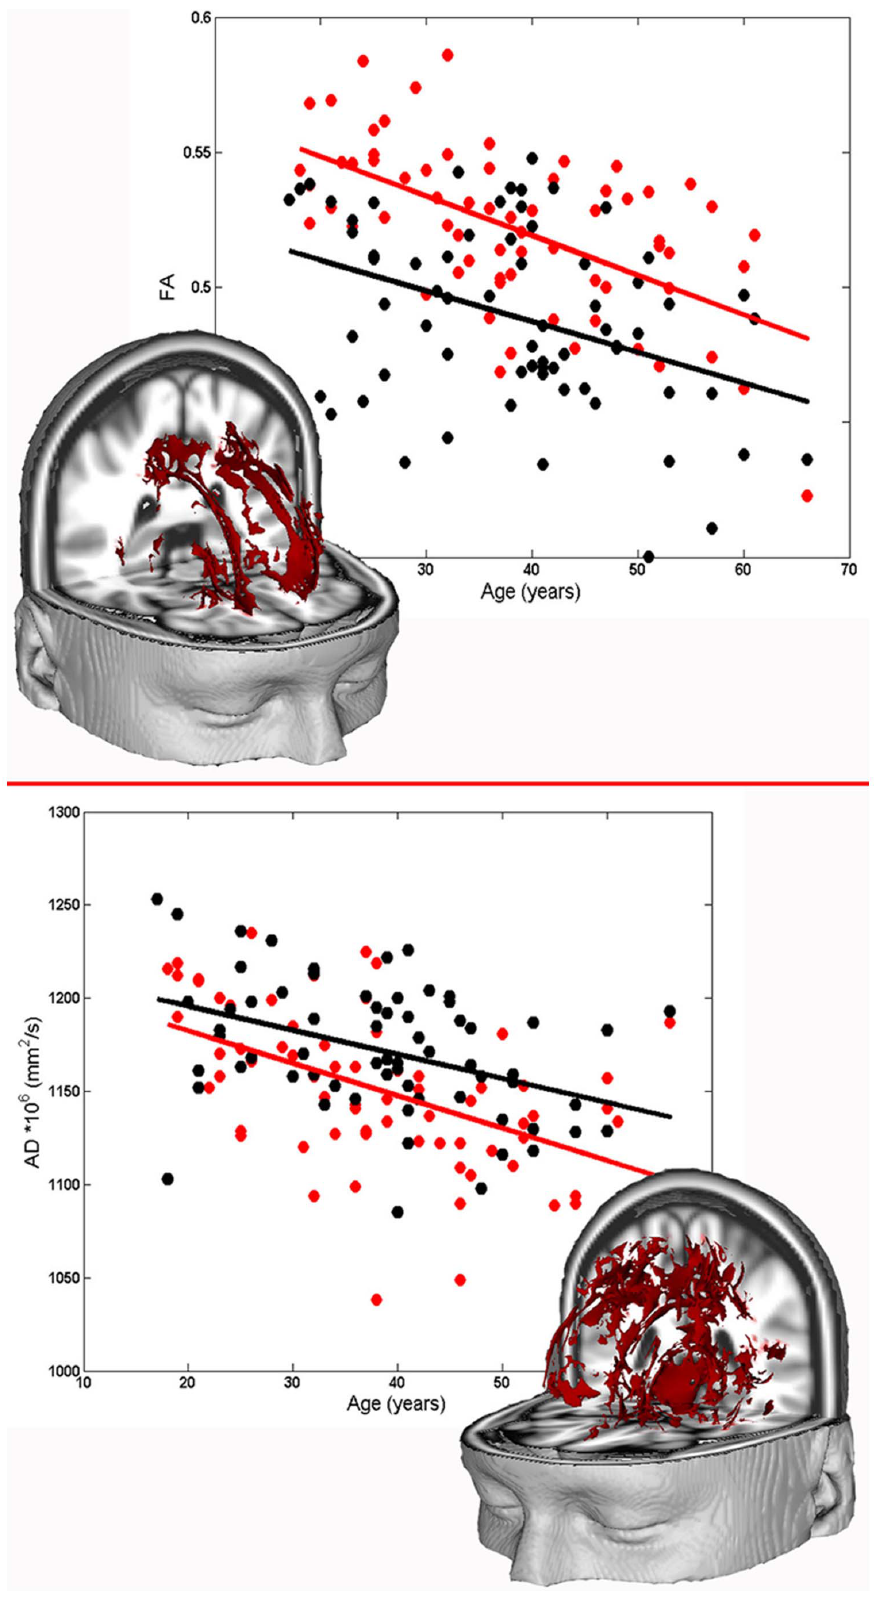
Figure 1. Age-related trajectories of WM DTI parameters of SZ and HC subjects. Upper part: three-dimensional representation of clusters in which a main effect of group characterizes the relationship between FA and age. The scatter plot shows the mean FA value in these clusters as a